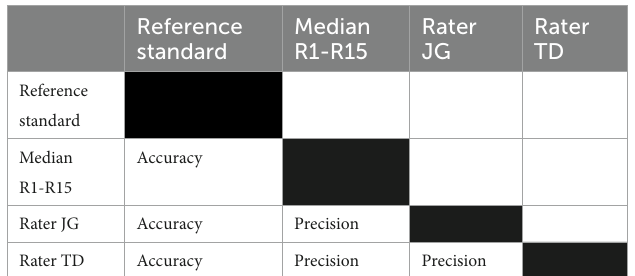
TABLE 1 Measures of accuracy and precision in the pilot